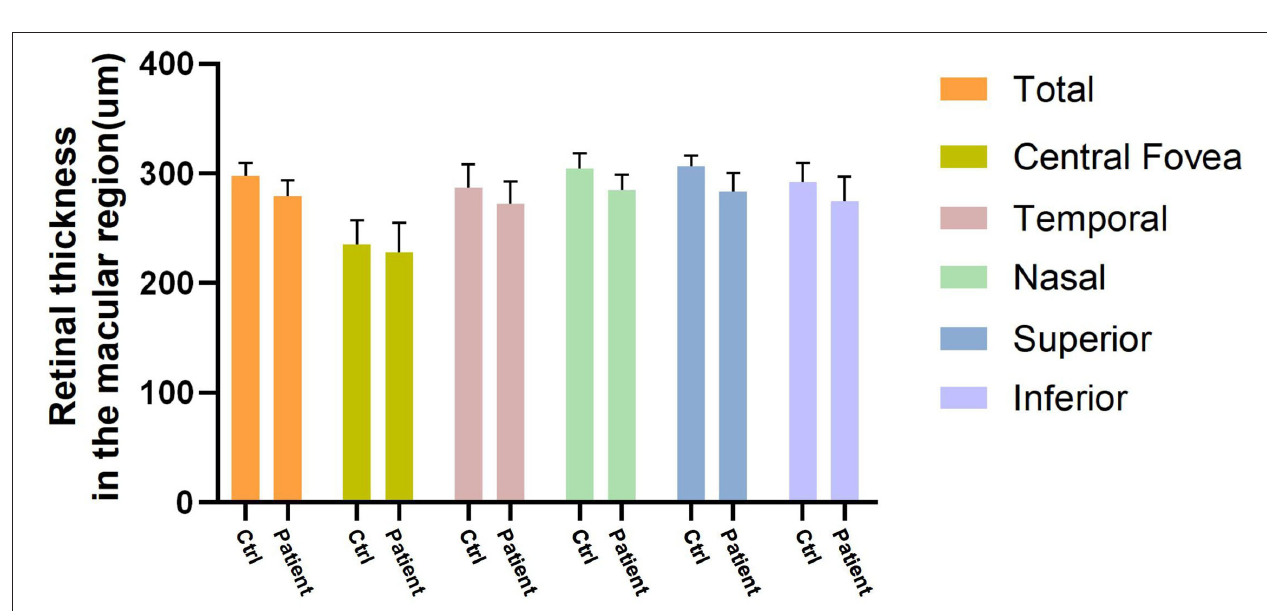
FIGURE 6 | Four quadrants of retinal thickness changes ( µ m) in the macular region between control group and prediabetes group.